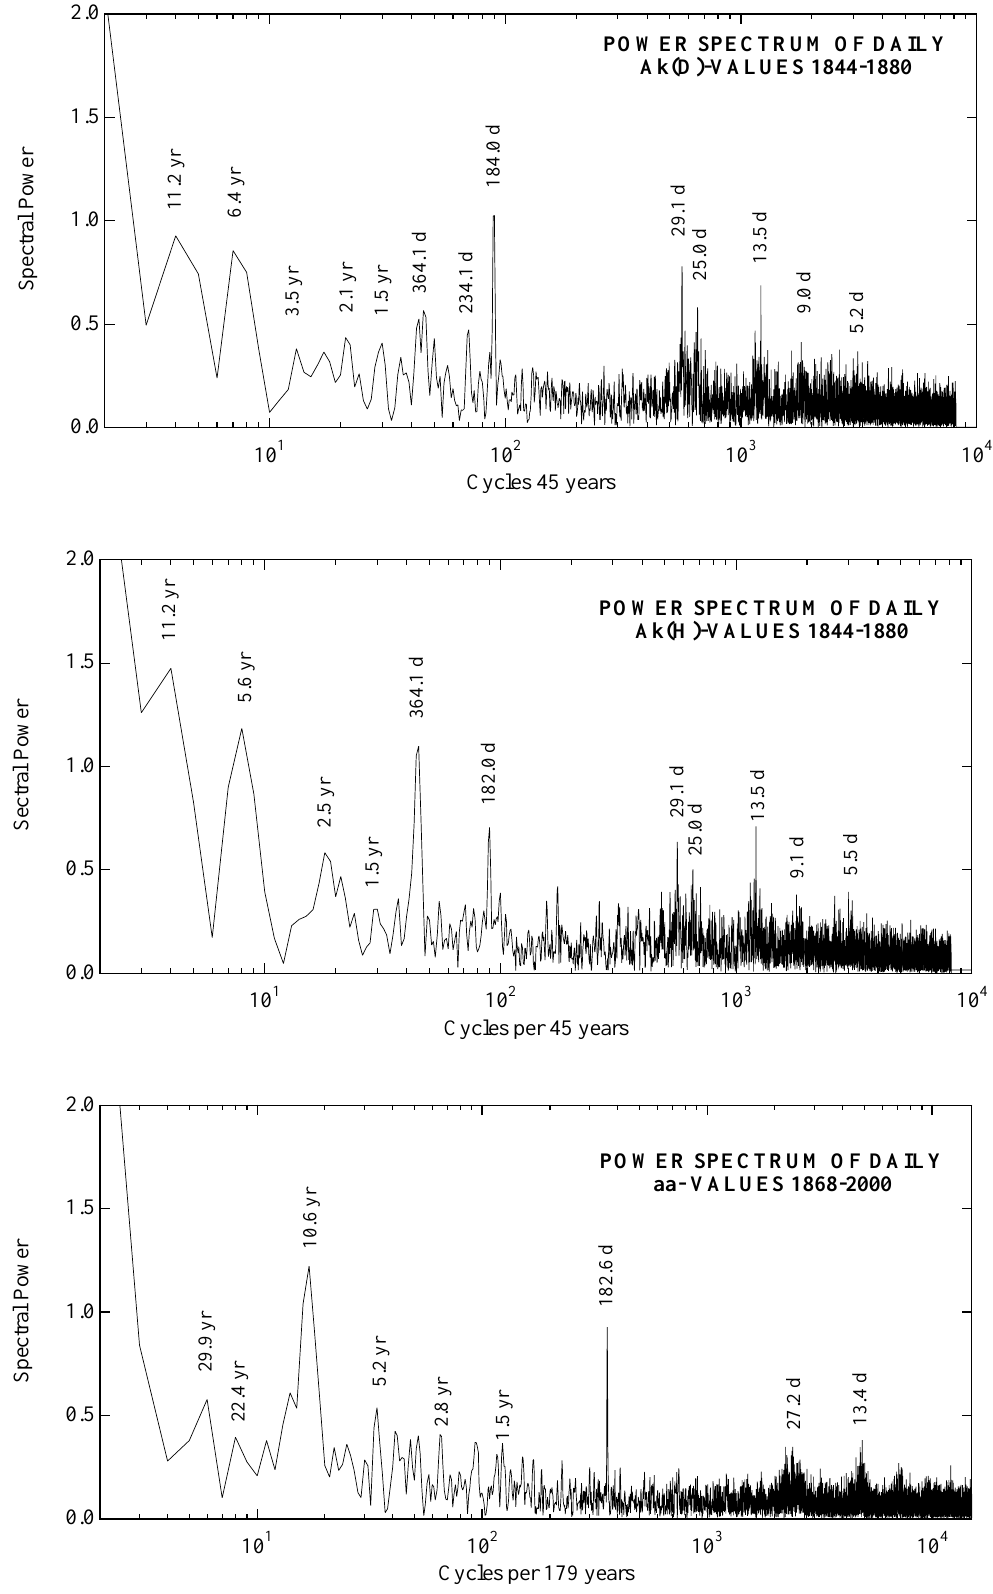
Fig. 4. Power spectra of daily Helsinki activity indices Ak(D) (top), Ak(H) (middle), and of aa